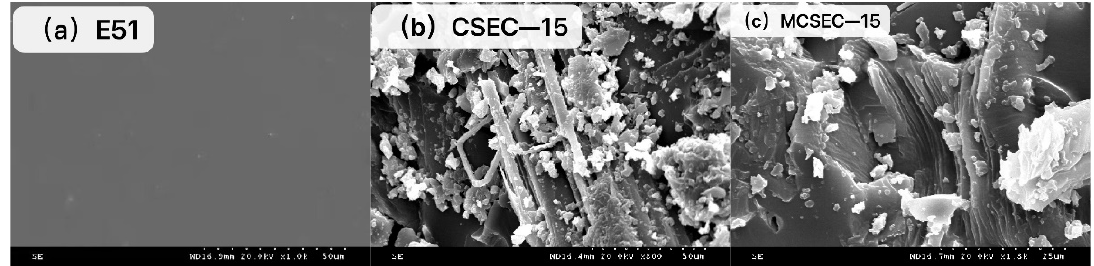
Figure 2. SEM of ( a ) pure E51, ( b ) CSEC-15 and ( c ) MCSEC-15.